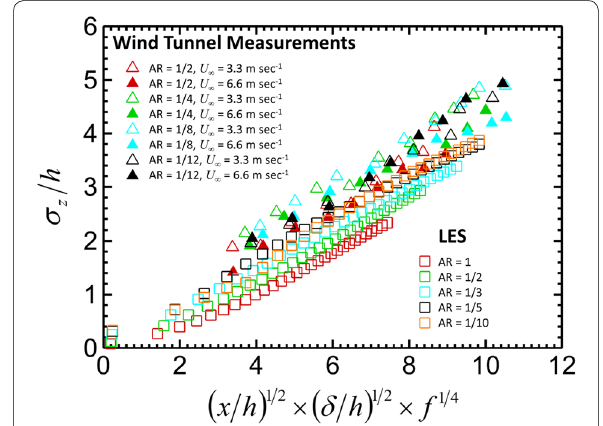
Fig. 6 Dimensionless profiles of vertical dispersion coefficient σ z plotted against streamwise distance x , TBL thickness δ and the friction factor